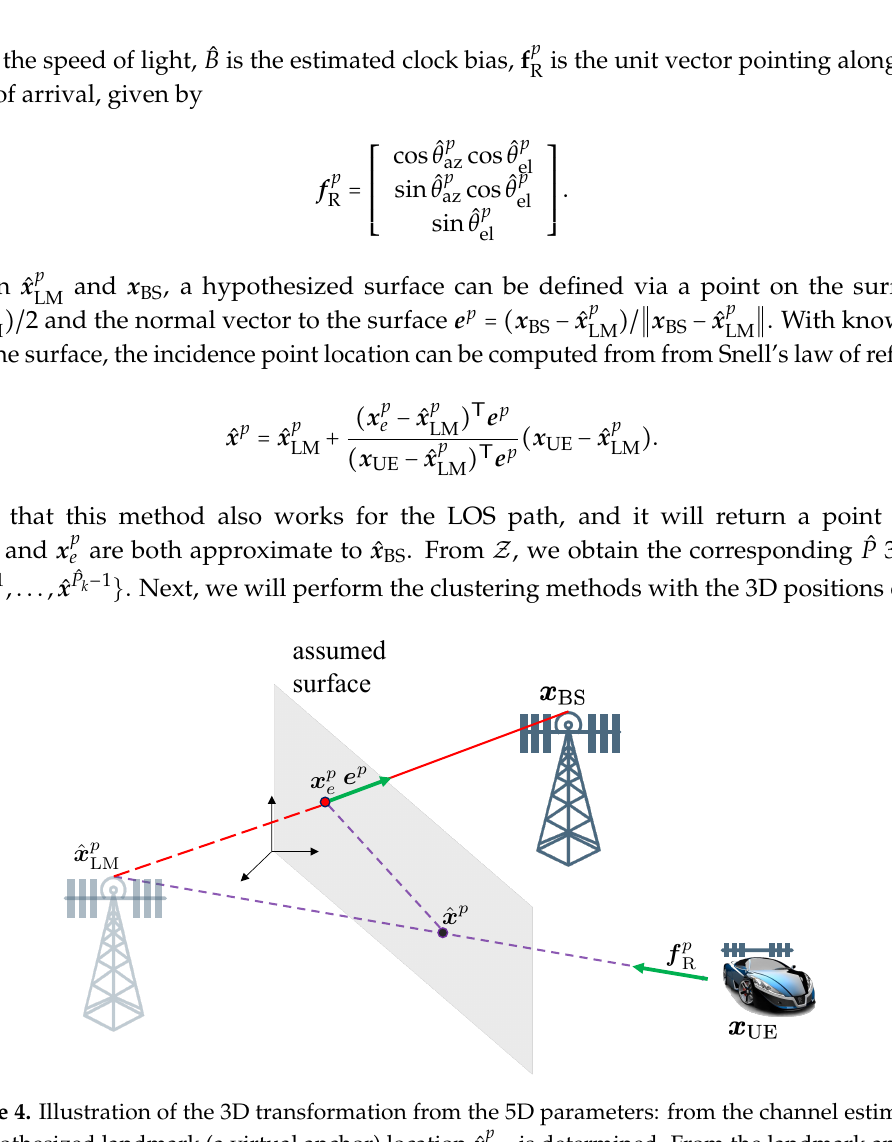
is determined. From the landmark and BS LM